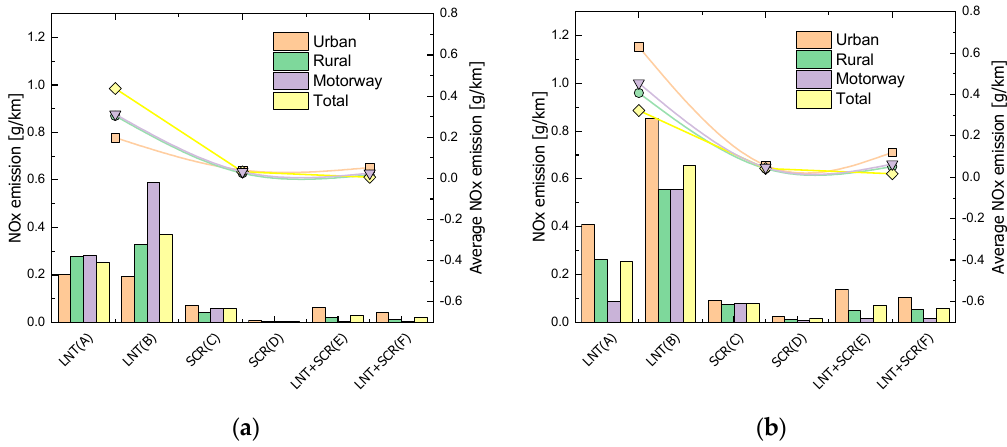
Figure 14. NO x emission characteristics of test vehicles in the RDE test according to after-treatment system. ( a ) Cold start; ( b ) Hot start.